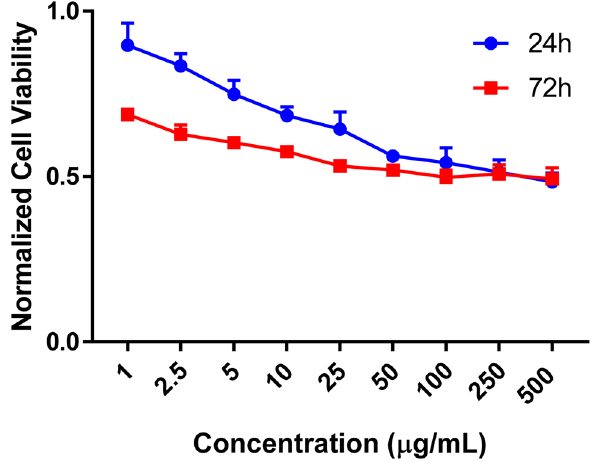
Figure 6. Cytotoxicity evaluation of boron